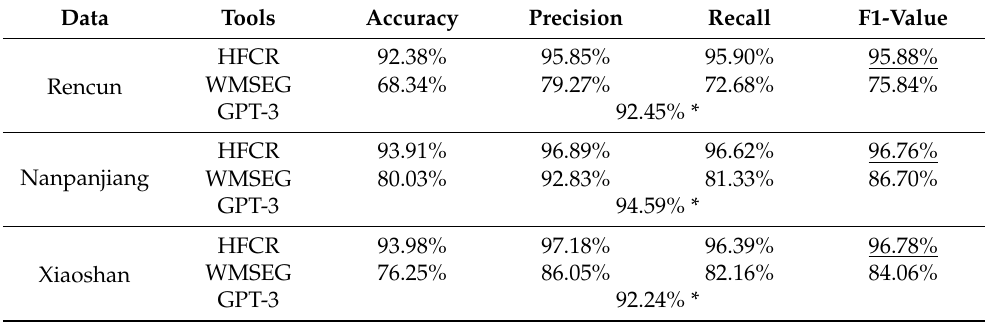
Table 6. Comparison of accuracy between HFCR algorithm and SOTA